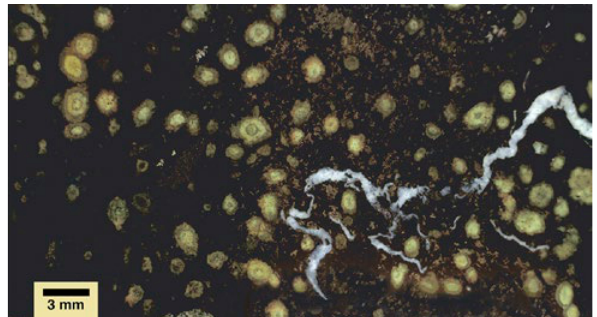
Figure 36. A quartz-magnetite-chlorite rock from the lower part of the Peko mineralised complex at Tennant Creek, NT, has concre- tionary rims developed round siliceous accretionary nuclei. These successive concretionary overgrowths on synerectic nuclei unmista- kably indicate the colloidal environment. Later ptygmatic and ‘clea- ner’ quartz veins have sinuously intruded the soft precursor quartz- chlorite-magnetite.